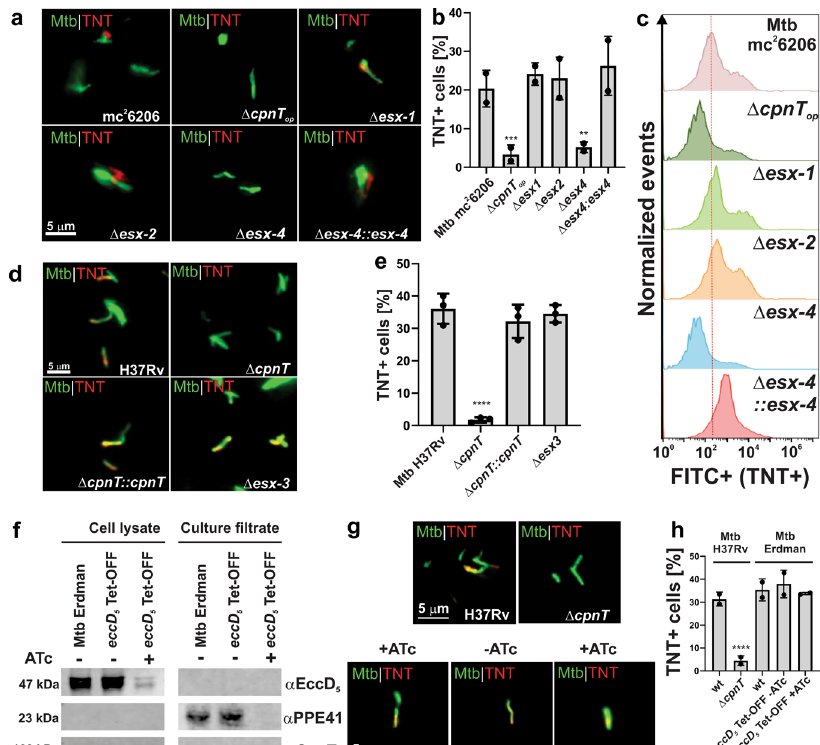
Fig. 2 The ESX-4 system is essential for CpnT export and surface accessibility in M. tuberculosis . a Detection of surface-accessible CpnT in Mtb using fl uorescence microscopy. The Mtb strains were labeled with DMN-trehalose (green) and stained with polyclonal anti-TNT and Alexa Fluor-594 secondary antibodies (red). b Quanti fi cation of TNT-positive Mtb cells from images shown in a . Mtb cells were scored as TNT-positive when a red signal was observed as compared with Mtb Δ cpnT op . c Surface accessibility of CpnT in Mtb by fl ow cytometry. The Mtb strains were stained with polyclonal anti-TNT and Alexa Fluor-488 secondary antibodies. The mean fl uorescence of Mtb cells is displayed in histograms. d Surface-accessibility of CpnT of the Mtb H37Rv esx-3 deletion mutant and the control strains by fl uorescence microscopy. The staining procedure was performed as in a . e Quanti fi cation of TNT- positive Mtb cells from images shown in d . Mtb cells were scored as TNT-positive when a red signal was observed as compared to Mtb Δ cpnT . f Depletion of a functional ESX-5 system in Mtb Erdman. The wt and eccD 5 Tet-OFF mutant strains were grown in the presence/absence of anhydrotetracycline hydrochloride (ATc; 100 ng/ml). Proteins from the whole-cell lysates and culture fi ltrates were analyzed by immunoblotting to detect EccD 5 , PPE41, and CpnT with speci fi c antibodies. g Surface-accessibility of CpnT in Mtb Erdman depleted of a functional Esx-5 system using fl uorescence microscopy. The staining procedure was performed as in a . The wt and Δ cpnT strains in the H37Rv background were used as positive and negative controls, respectively. h TNT-positive Mtb cells from images shown in g were quanti fi ed as described in e . The Δ esx-1 strain has a deletion of the RD1 region and lacks the panCD genes. Data are represented as mean ± SEM of at least two independent experiments ( n ≥ 2) and representative images/blots are shown. Asterisks indicate signi fi cant differences (* p value ≤ 0.05, ** p value ≤ 0.01, *** value ≤ 0.001, **** p value ≤ 0.0001, calculated using the one-way ANOVA with Dunnett ’ s correction) compared with the corresponding wt strain. Source data are provided in the Source Data fi